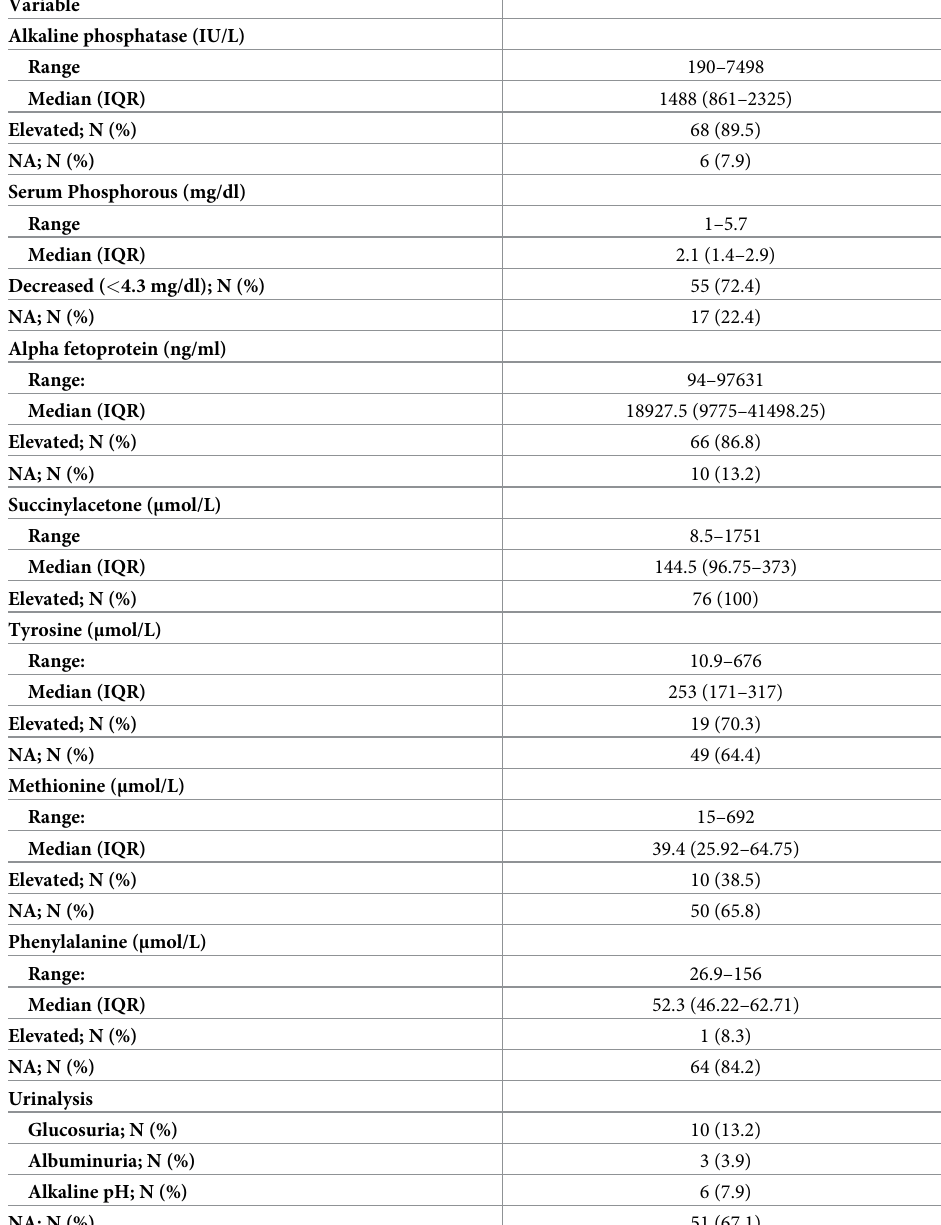
Table 4. Relevant biochemical tests of 76 hepatorenal tyrosinemia